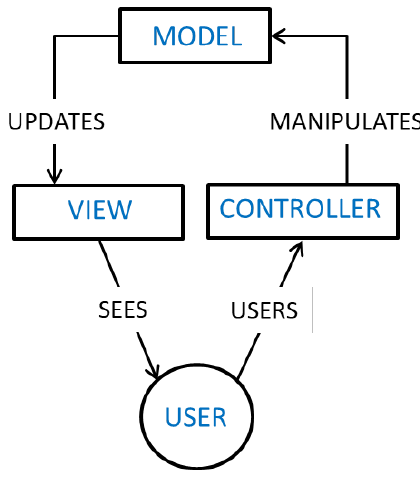
Figure 2. Application for geographical data handling.